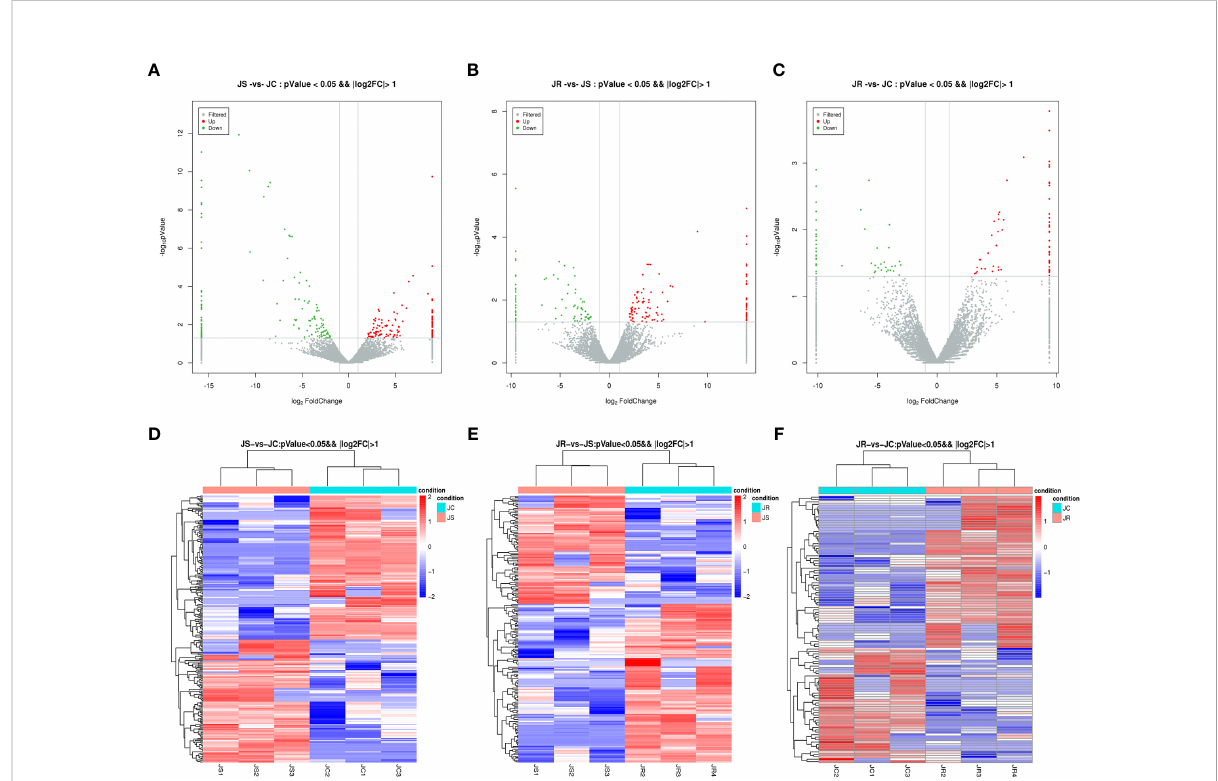
FIGURE 3 Expression pro fi les of differentially expressed circRNAs in chicken cecal tissues of different groups during E . tenella infection. (A – C) Volcano plots of differentially expressed lncRNAs in the JS vs JC group (A) , JR vs JS group (B) , and JR vs JC group (C) . (D – F) Hierarchical clustering plots of differentially expressed lncRNAs in the JS vs JC group (D) , JR vs JS group (E) , and JR vs JC group (F) .